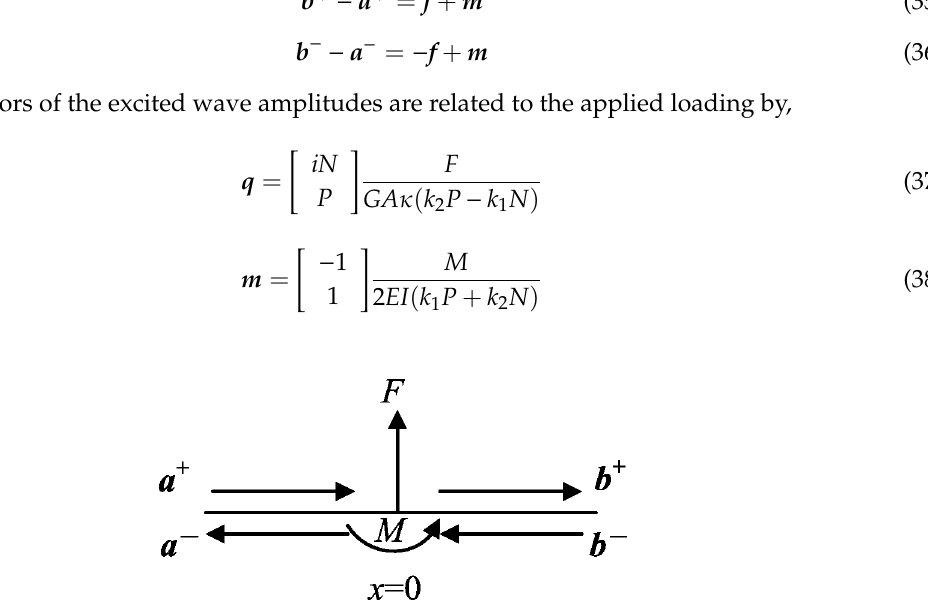
Figure 4. Waves generated by external forces and moment.